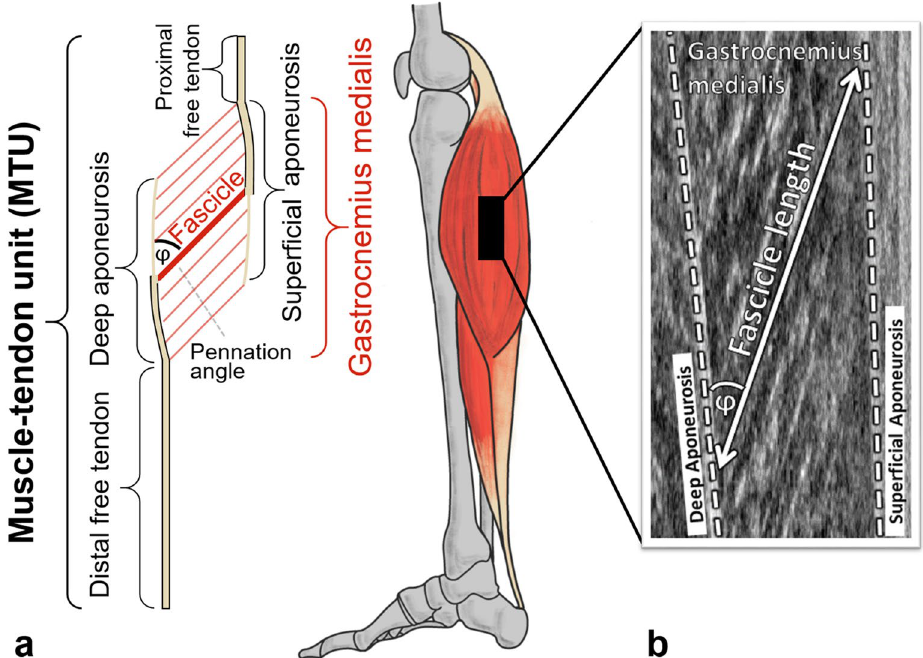
Figure 4. Schematic and anatomical muscle–tendon unit model ( a ) in addition to an actual annotated ultrasound image of the gastrocnemius medialis ( b ). The series elastic element consists of all tendon-like elements, i.e. free tendon and aponeuroses, as shown in beige ( a ). The pennation angle (φ) of the muscle fascicles is defined with respect to the deep aponeurosis. Fascicle length is measured as the length following the pennation between the deep and the superficial aponeuroses ( b